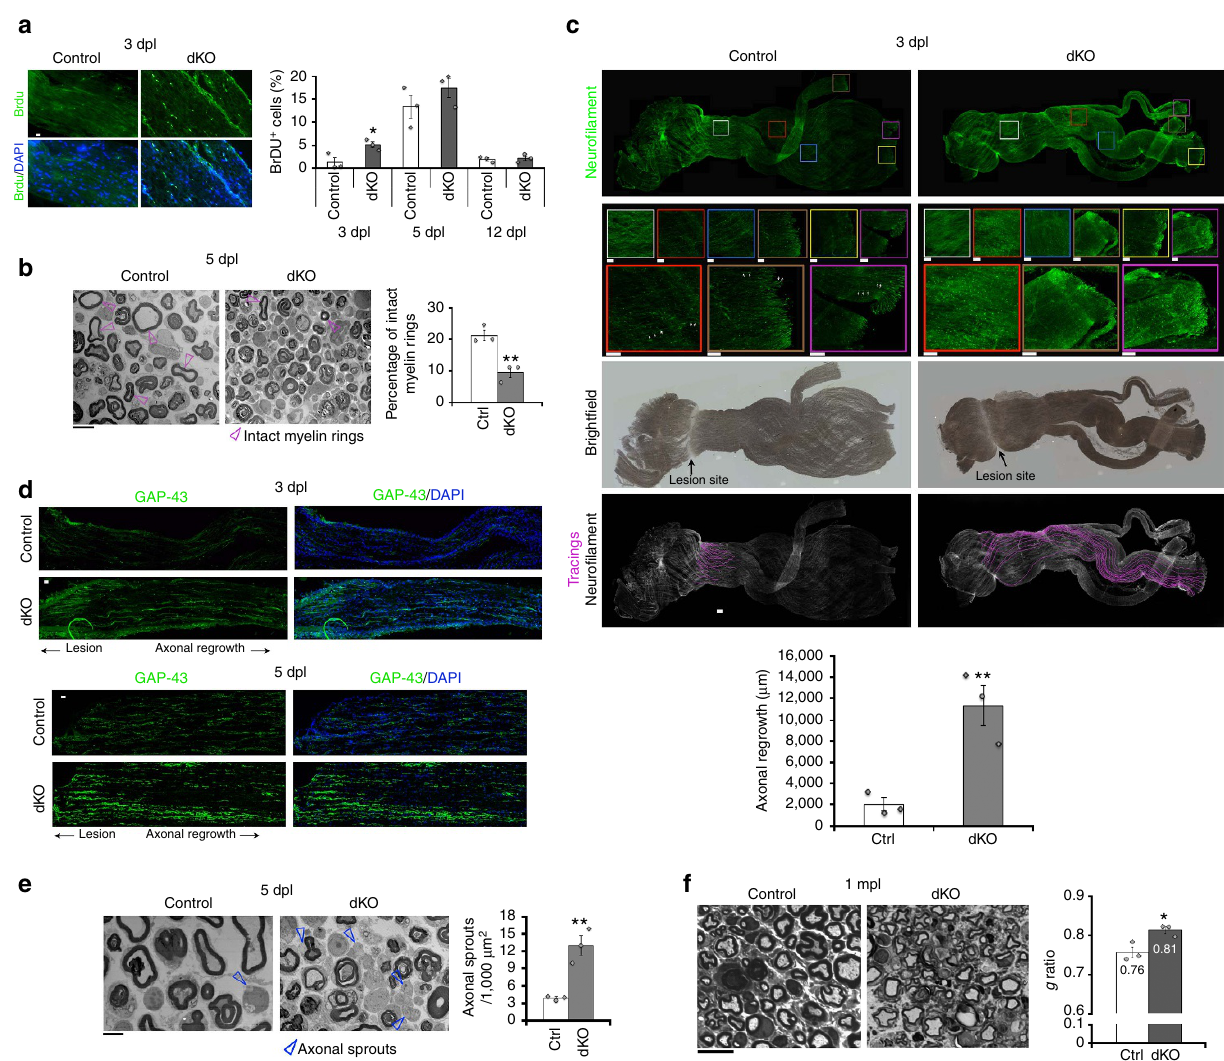
Figure 2 | HDAC1/2 slow down axonal regrowth but promote remyelination. ( a ) BrdU incorporation (green) and DAPI (blue) identifying earlier induction of proliferation in dKO compared to control nerves. Scale bar ¼ 10 m m. Electron micrographs ( b , e ) and toluidine-blue staining ( f ) and quantification showing in dKO compared to controls a decreased percentage of intact myelin rings ( b , scale bar ¼ 10 m m) and increased number of axonal sprouts ( e , Scale bar, 5 m m) at 5 dpl, and thinner remyelinating sheaths at 1 month post lesion (mpl) (higher g ratio in dKO, ( f ), Scale bar, 10 m m). ( c ) Z -series projections of whole-nerve Neurofilament immunofluorescence in control and dKO nerves, brightfield showing lesion site and axonal tracings (acquired using NeuronJ, Scale bar, 300 m m) quantifying axonal regrowth from the lesion site. White arrows, fragmented axons. Coloured boxes, magnifications (Scale bar, 100 m m). ( d ) Z -series projections of GAP-43 immunofluorescence (green) and DAPI labelling (blue ¼ nuclei) showing strongly increased GAP-43 expression in dKO compared with control nerves at 3 dpl (20- m m thick cryosections) and 5 dpl (5- m m thick cryosections). Scale bar, 30 m m. Note that immunofluorescence staining of 3 dpl sections was not carried out at the same time as staining of 5 dpl sections, and imaging was also done separately with different exposure times. Unpaired two-tailed Student’s t -tests, P values: * P o 0.05, ** P o 0.01. Values, mean, error bars, s.e.m. Sample size: n ¼ 3 animals per group per time point for all graphs, electron microscopy and immunofluorescence. ( a ) Number of cells counted: 334 to 469 per animal at 3 dpl (per genotype: 1,218 for controls, 1,140 for dKO); 111 to 727 per animal at 5 dpl (per genotype: 1,779 for controls, 1,262 for dKO); 553 to 4,380 per animal at 12 dpl (per genotype: 5,440 for controls, 8,892 for dKO). ( b ) Number of myelin rings counted: 344 to 469 per animal. ( c ) Number of tracings: 10 to 25 per nerve. ( d ) Surface of nerve ultrathin section counted: 0.026 to 0.03mm 2 per animal. ( e ) 60–70 myelinated axons (randomly chosen) counted per nerve. The g ratio (axon diameter: axon þ myelin diameter) of both contralateral (0.71 for control and 0.72 for dKO nerves, P value ¼ 0.32: no significant difference between control and dKO) and crushed nerves was measured.